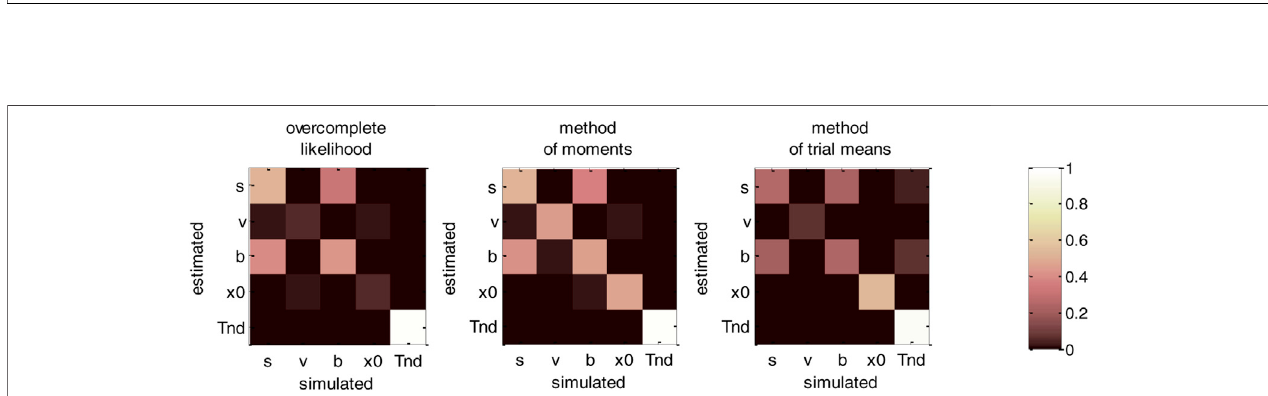
FIGURE 7 | Comparison of simulated and estimated DDM parameters (full parameter set). Left panel: Estimated parameters using the overcomplete approach ( y -axis) are plotted against simulatedparameters( x -axis).Each dot isamonte-carlo simulationand different colorsindicate distinctparameters (blue: σ , red: v ,yellow: b , purple: x 0 , green: T ND ). The black dotted line indicate the identity line (perfect estimation). Middle panel: Method of moments, same format as left panel. Right panel: Method of trial means, same format as left panel.